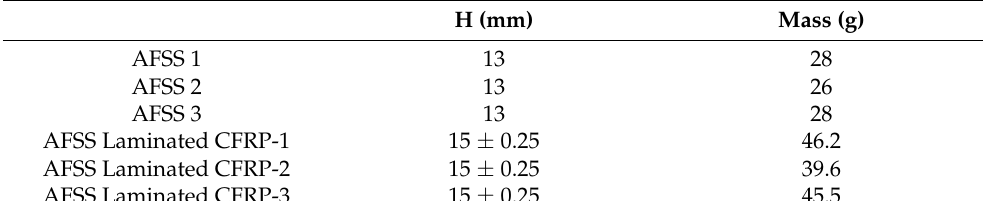
Table 3. Mass and beam depth for bending tests.